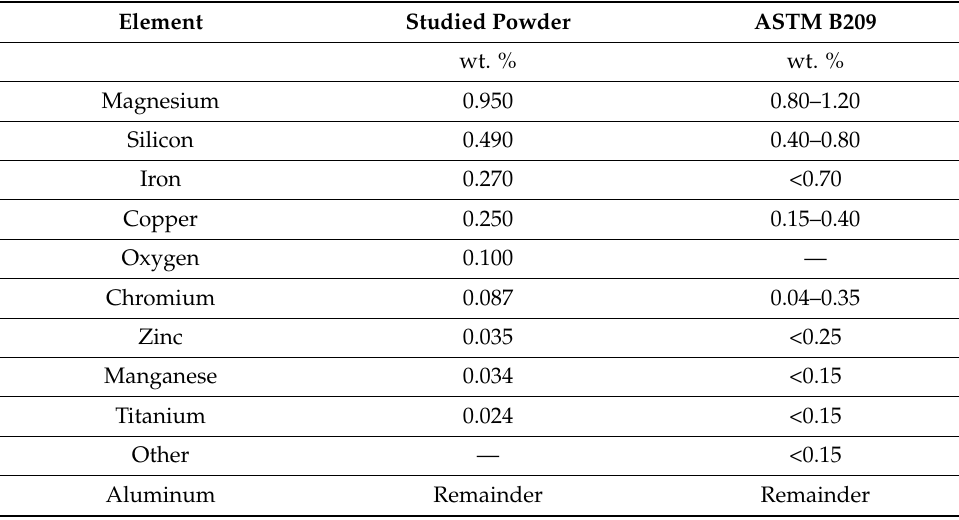
Table 1. Elemental composition of studied powder and ASTM